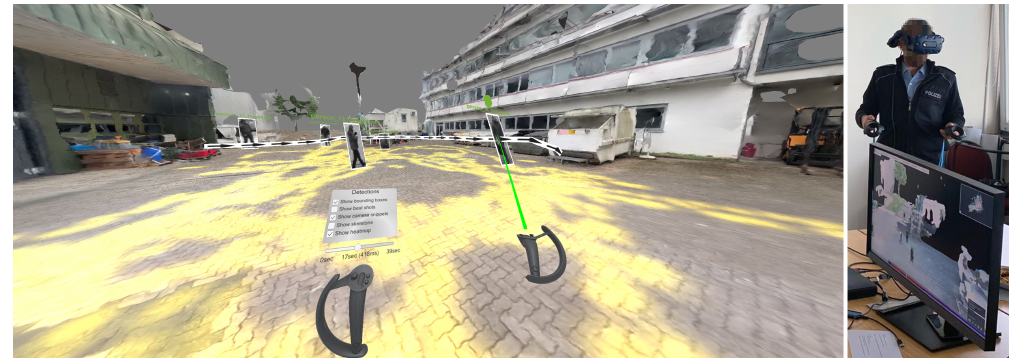
Figure 28. ( Left ) View of an exemplary scene in VR. ( Right ) Set-up with immersed investigator. For further interactions, the user can open a menu by placing the thumb on the right joystick (see Figure 29, left). The joystick can be moved around and released at the desired option to select an item on the radial menu. The selected menu opens and is attached to the left controller. Options can then be selected by pointing the laser on the right controller at them and pressing the right trigger button. In this way, it is possible to modify the appearance of the scene (“Layer Options”), the display of detections (“Detections”), and the annotation of the scene (“Annotation Options”). The user can either drag the slider attached to the left controller or use the left joystick to scroll forward and backward to navigate in time.